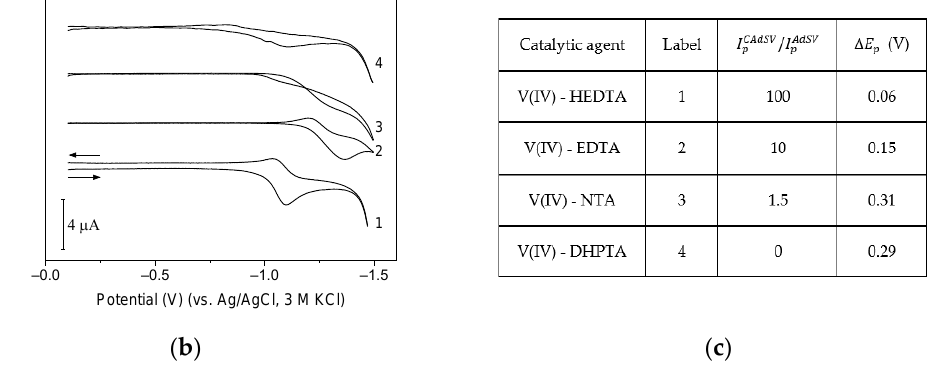
Figure 12. ( a ) Solutions containing 1 mM of V(IV) (0), 1 mM of V(IV) and 2 mM of HEDTA (1), 1 mM of V(IV) and 2 mM of EDTA (2), 1 mM of V(IV) and 2 mM of NTA (3) and 1 mM of V(IV) and 2 mM of DHPTA (4) in polystyrene cuvettes. ( b ) CV voltammograms recorded in 0.05 M acetate buffer containing 1 mM of V(IV) and 2 mM of HEDTA (1), 2 mM of EDTA (2), 2 mM of NTA (3) or 2 mM of DHPTA (4); scan rate = 50 mVs −1 ; ( c ) Amplification factors measured for Ge(IV) signals obtained using different catalytic agents and the corresponding peak-to-peak separation (Δ E p ) of the vanadium redox couple. Reprinted with permission from ref. [42]. Copyright 2020 John Wiley and Sons.